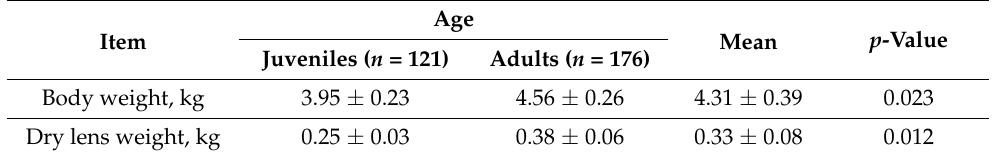
Table 1. Body weight and dry lens weight in the two age groups.